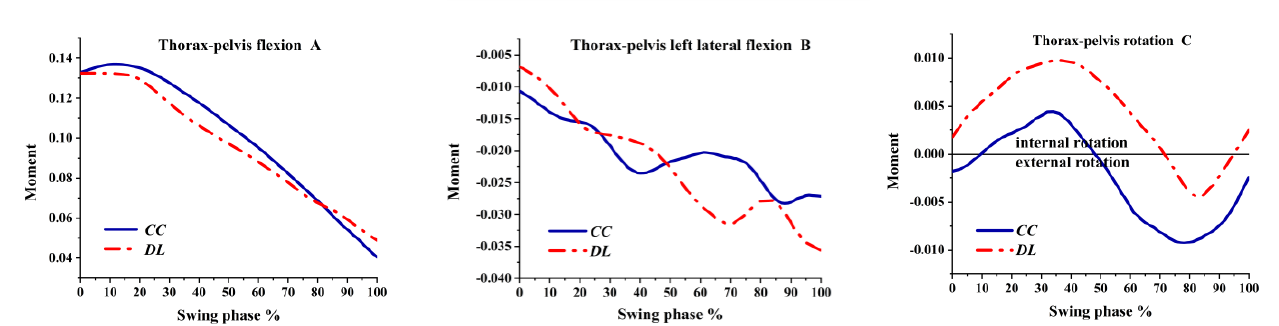
Figure 14. The moment of thorax – pelvis during swing phase.